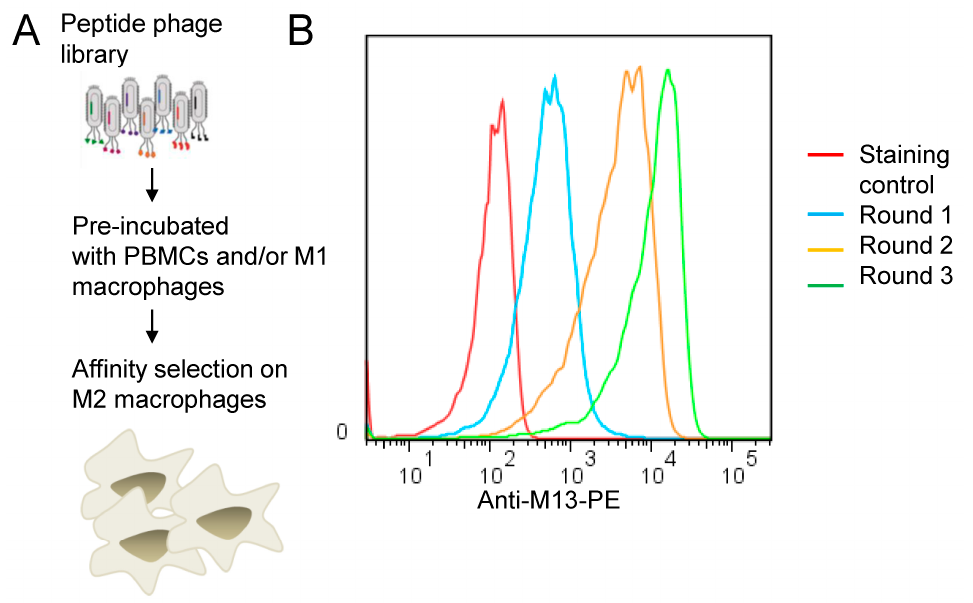
Figure 1. ( A ) Biopanning on M2 macrophages. Schematic representation of the biopanning protocol.